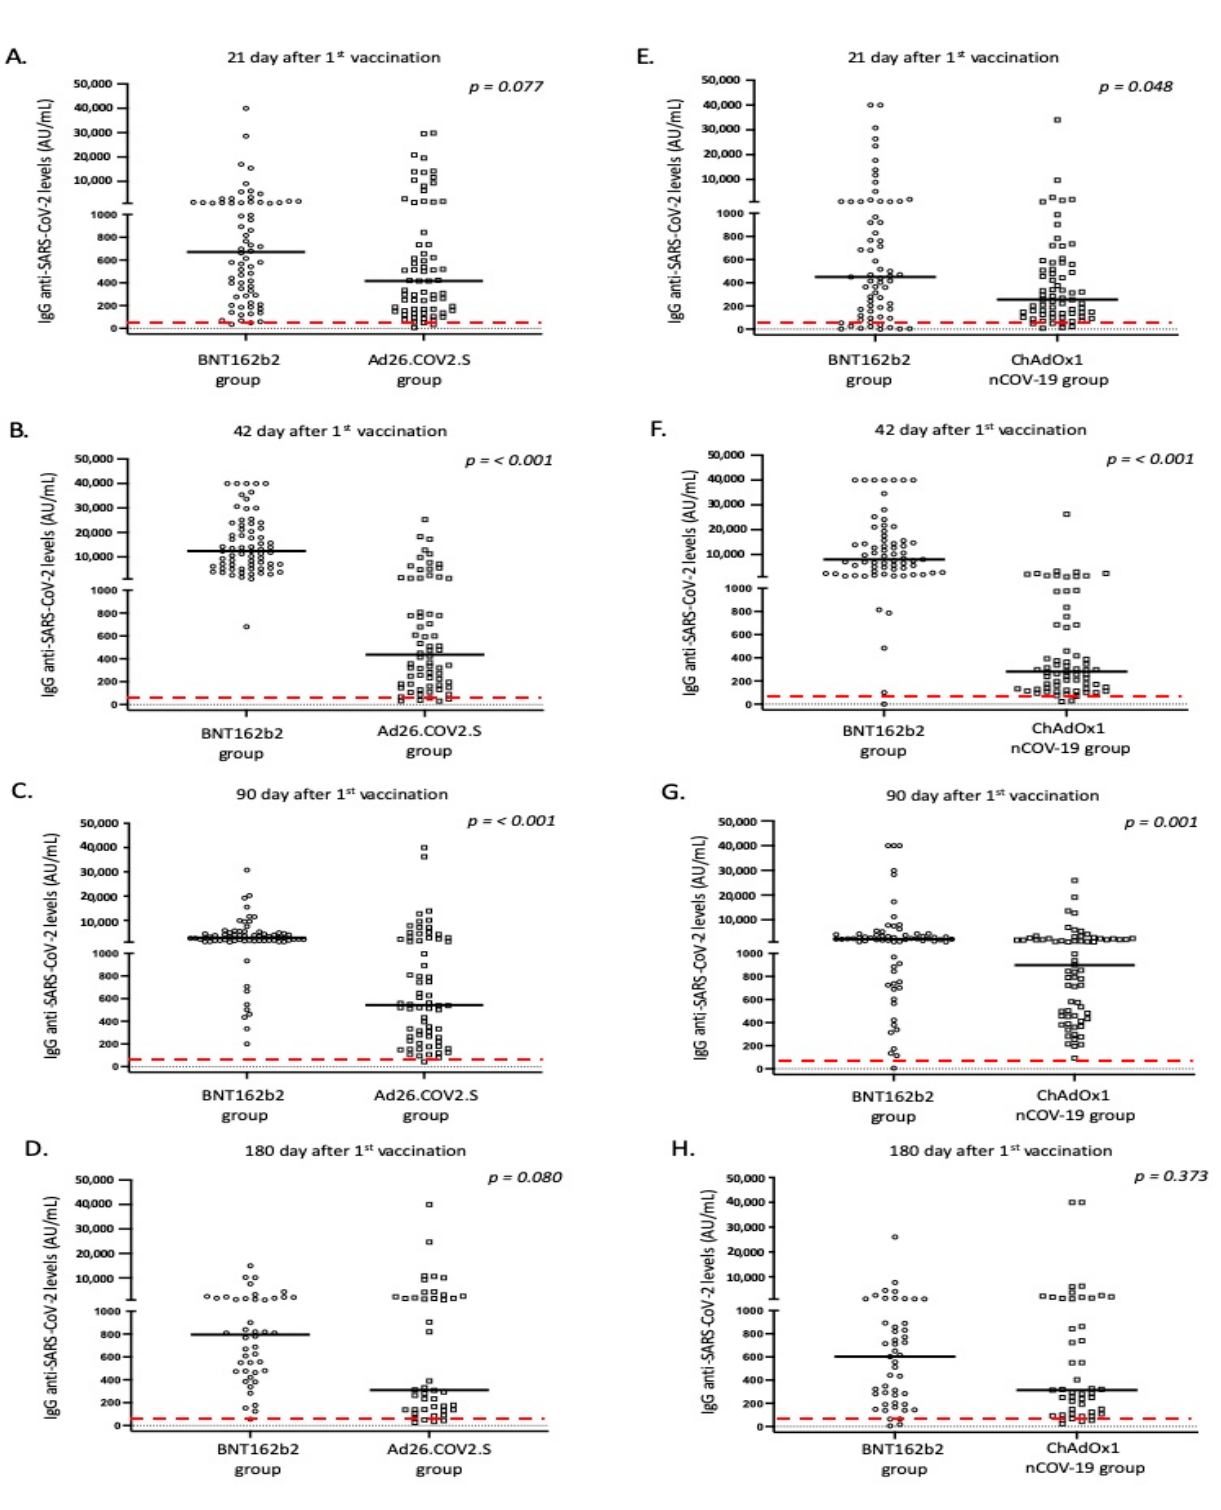
Figure 1. IgG anti SARS-CoV-2 responses in the study participants according to vaccine platform: red dotted lines represent the cutoff of positive anti-SARS-CoV-2 IgG (50 AU/mL) antibodies.